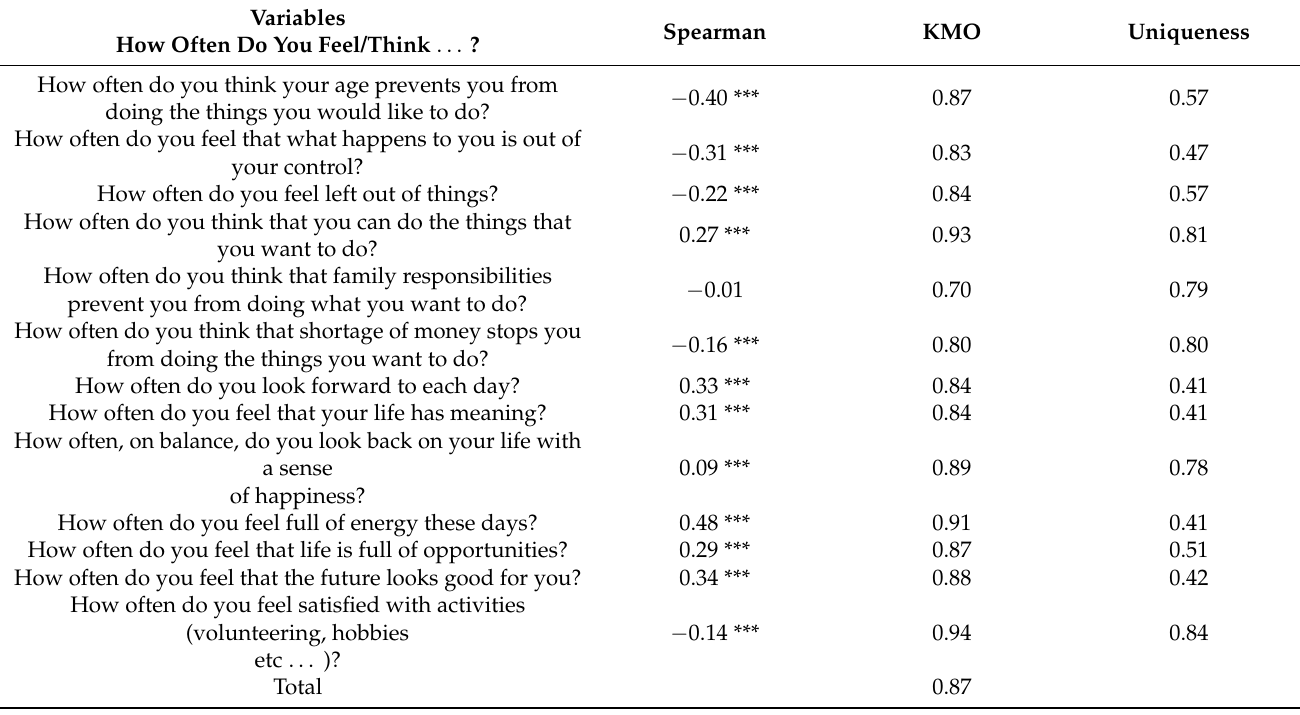
Table 2. Variables selected from the SHARE questionnaire and statistical analysis: Spearman, KMO and